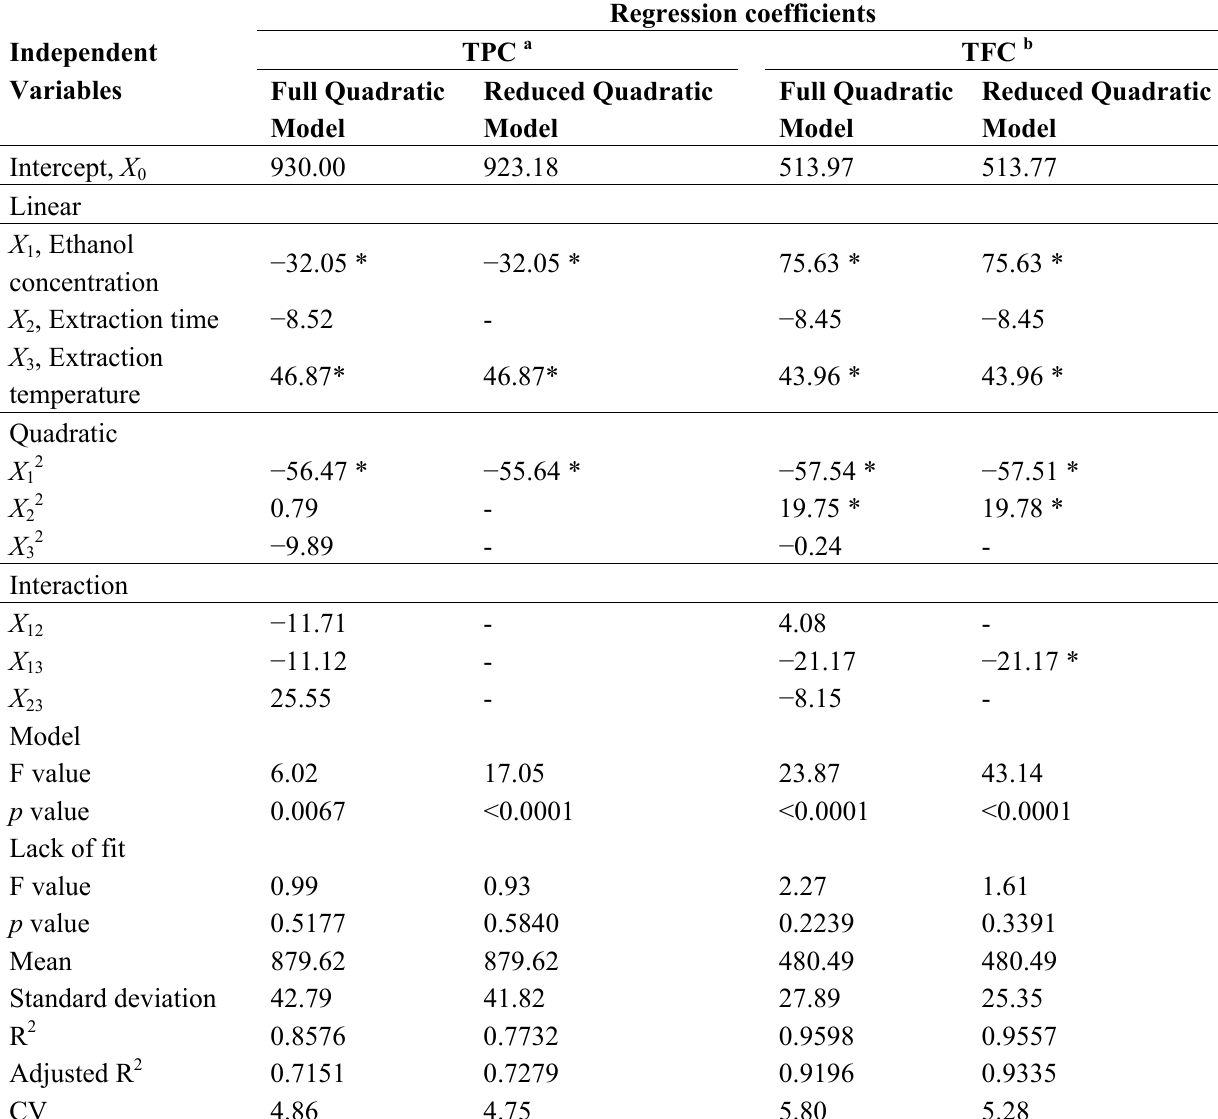
Table 1. Estimated regression coefficients of the second-order polynomial model for three dependent variables of mengkudu ( Morinda citrifolia ) crude